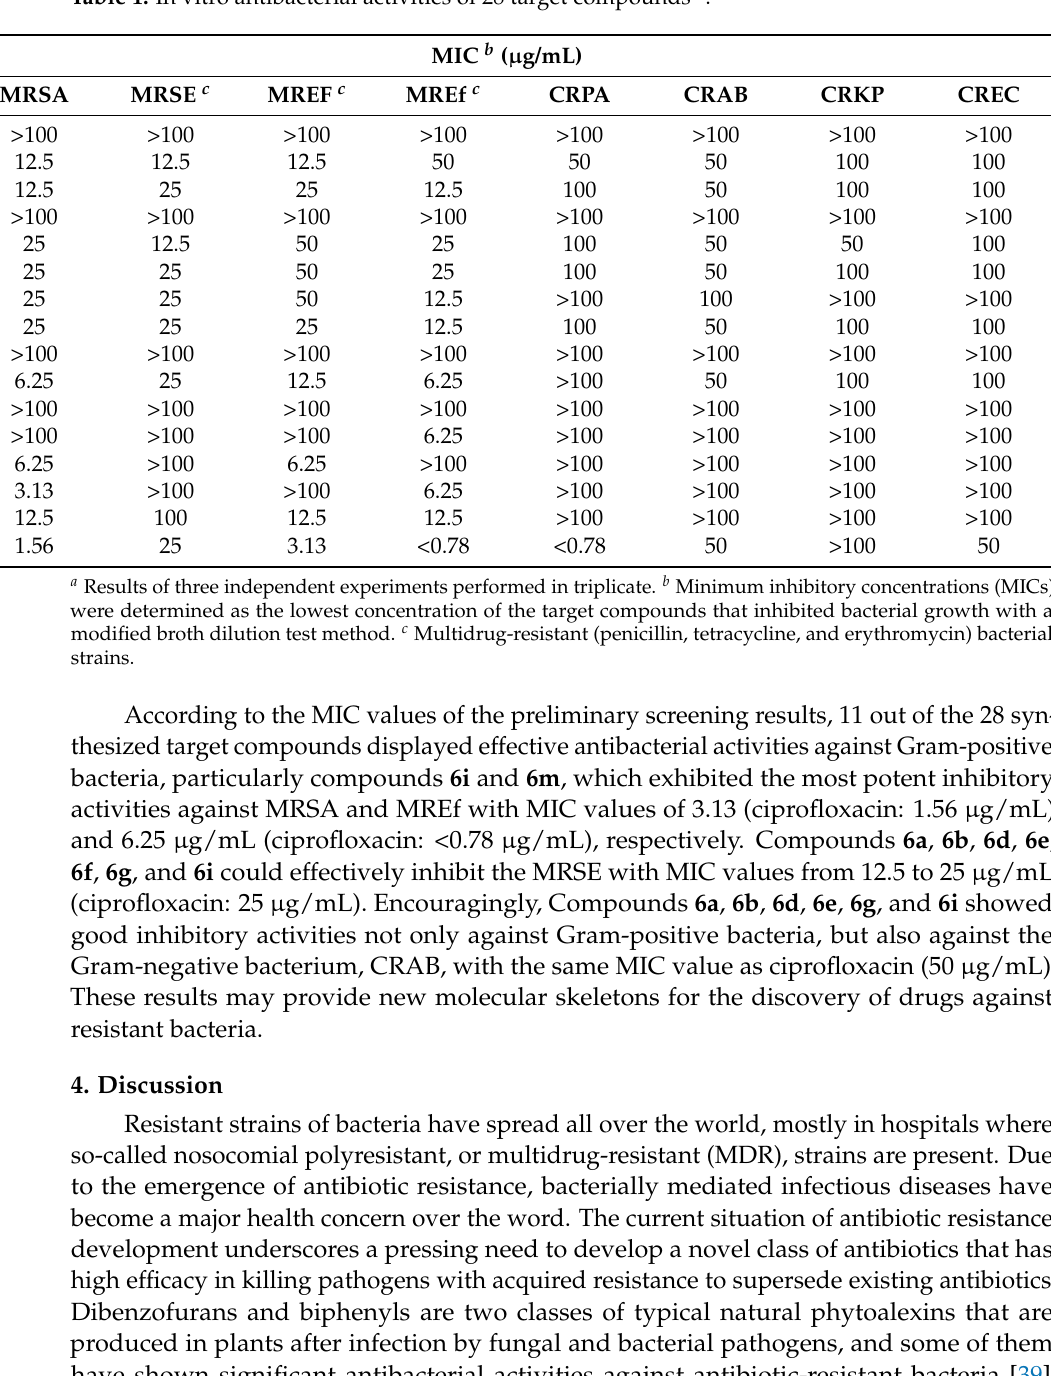
Table 1. In vitro antibacterial activities of 28 target compounds a